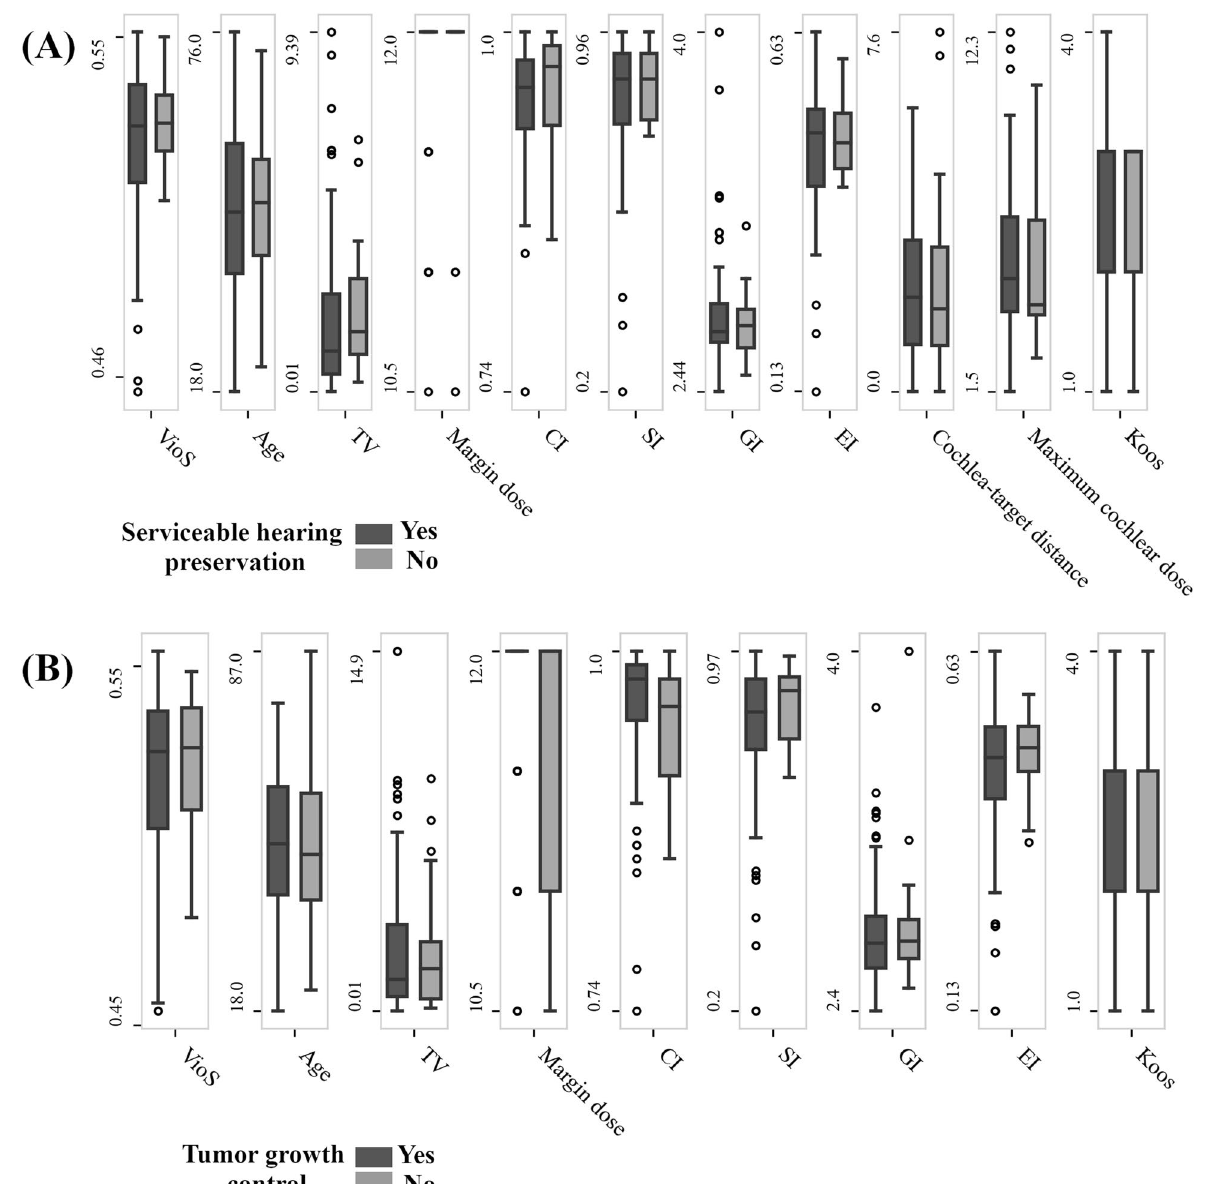
Figure 4. Comparisons of clinical and treatment parameters of vestibular schwannoma patients with or without hearing preservation ( A ) and tumor growth control ( B